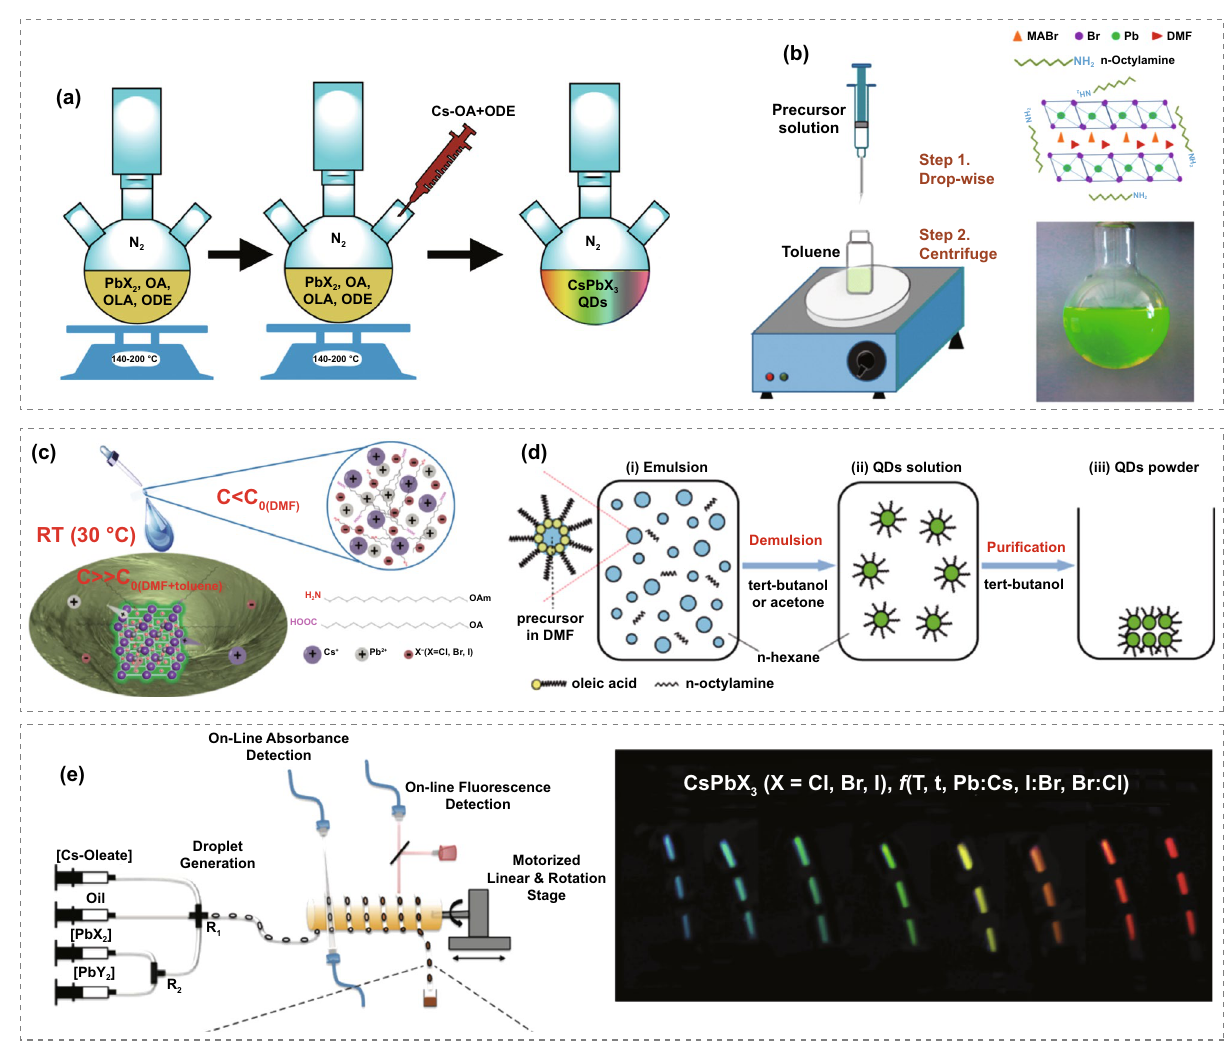
Fig. 2 a Schematic diagram of the hot-injection method for synthesizing inorganic perovskite QDs. b Schematic diagram of LARP method for inorganic perovskite QDs fabrication. Adapted with permission from Ref. [95]. Copyright 2015, American Chemical Society c Schematic dia- gram of the ligand-assisted method. Adapted with permission from Ref. [96]. Copyright 2016, Wiley–VCH. d Schematic diagram of the mecha- nism of the emulsion method. Adapted with permission from Ref. [97]. Copyright 2015, American Chemical Society. e Schematic diagram of the microfluidic method and the photo of obtained CsPbX 3 QDs under UV excitation. Adapted with permission from Ref. [104]. Copyright 2016, American Chemistry